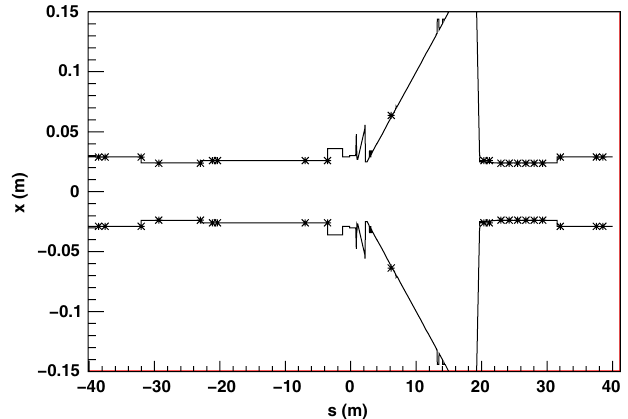
FIG. 6. (Color) The aperture model of the LHCb interaction region. The Q1 magnet on the right-hand side is located at the dense row of